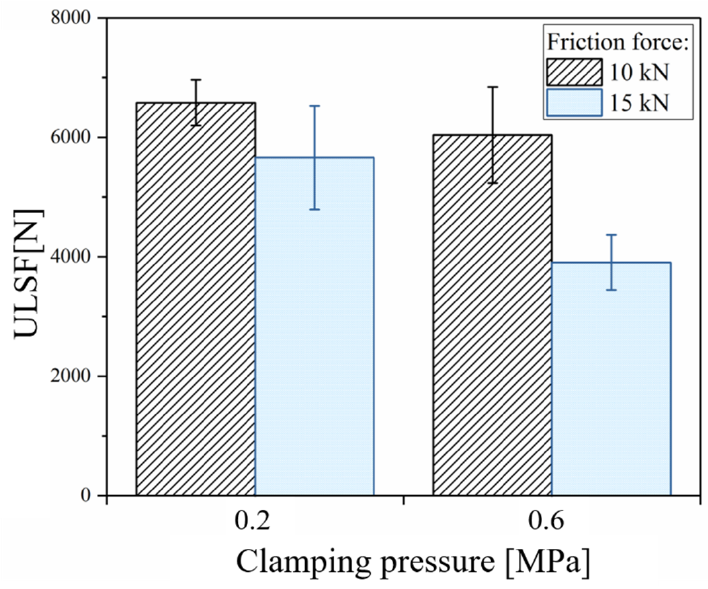
Figure 15. Effect of the friction force and clamping pressure on the ultimate lap-shear force (ULSF) of friction-riveted joints. (Joining parameters - RS: 15,000 rpm, DF: 7.5 mm).